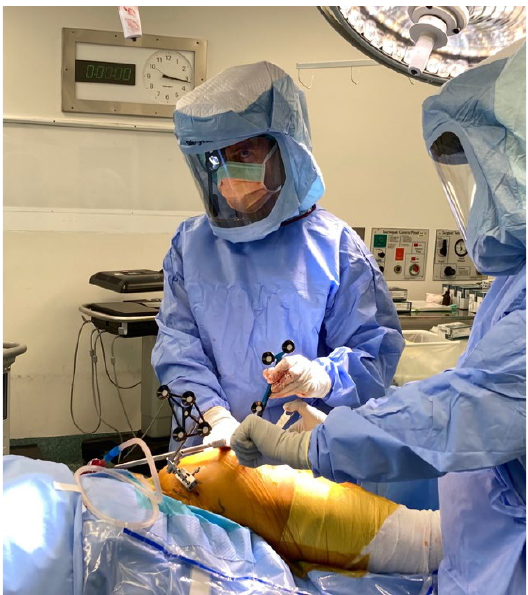
Figure 6. Tracking array positioned in iliac crest with hand-held array to map the acetabulum.